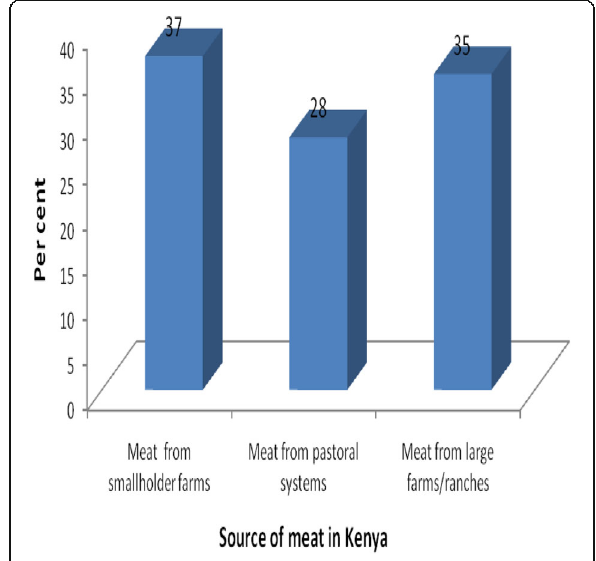
Fig. 3 The contribution of pastoralism to the national meat output